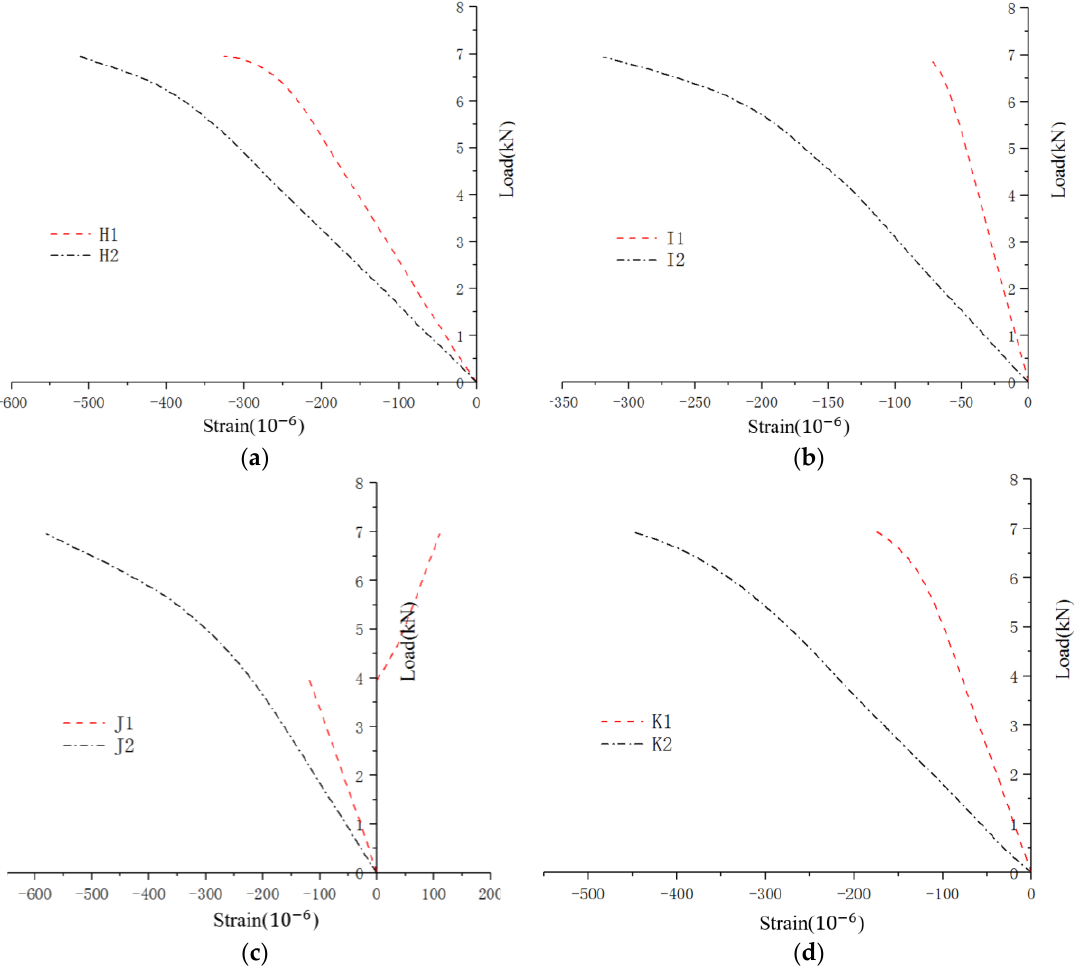
Figure 8. Load-strain relationship of the new composite thin-shell: ( a ) Position H; ( b ) Position I; ( c ) Position J; ( d ) Position K.